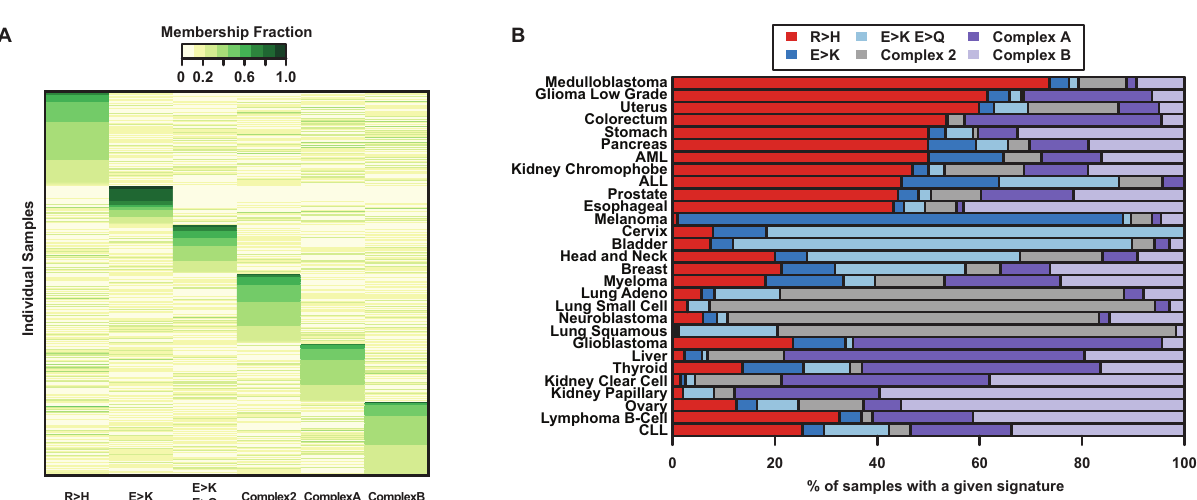
Fig 2. Amino acid mutation signatures for individual samples. (A) A heatmaprepresentation of the six-component NMF clustering results for individualcancer samples(only those with > 10 total nonsynonymous mutations). Samples with the same maximum signature componentwere groupedand sorted. Four amino acid mutation signatures identified(R > H, E > K, E > K/E > Q, Complex 2) overlap with signaturesin Fig 1A. Color scale representsscaled contributionof each signaturefor a given sample. Signatureand NMF fit detailscan be found in S3 Fig. (B) Bars show the total fraction of individual sampleswith a majority of a particular signature within each cancer. Within cancers, a large fraction of individualsamples tend to have similar signature components.